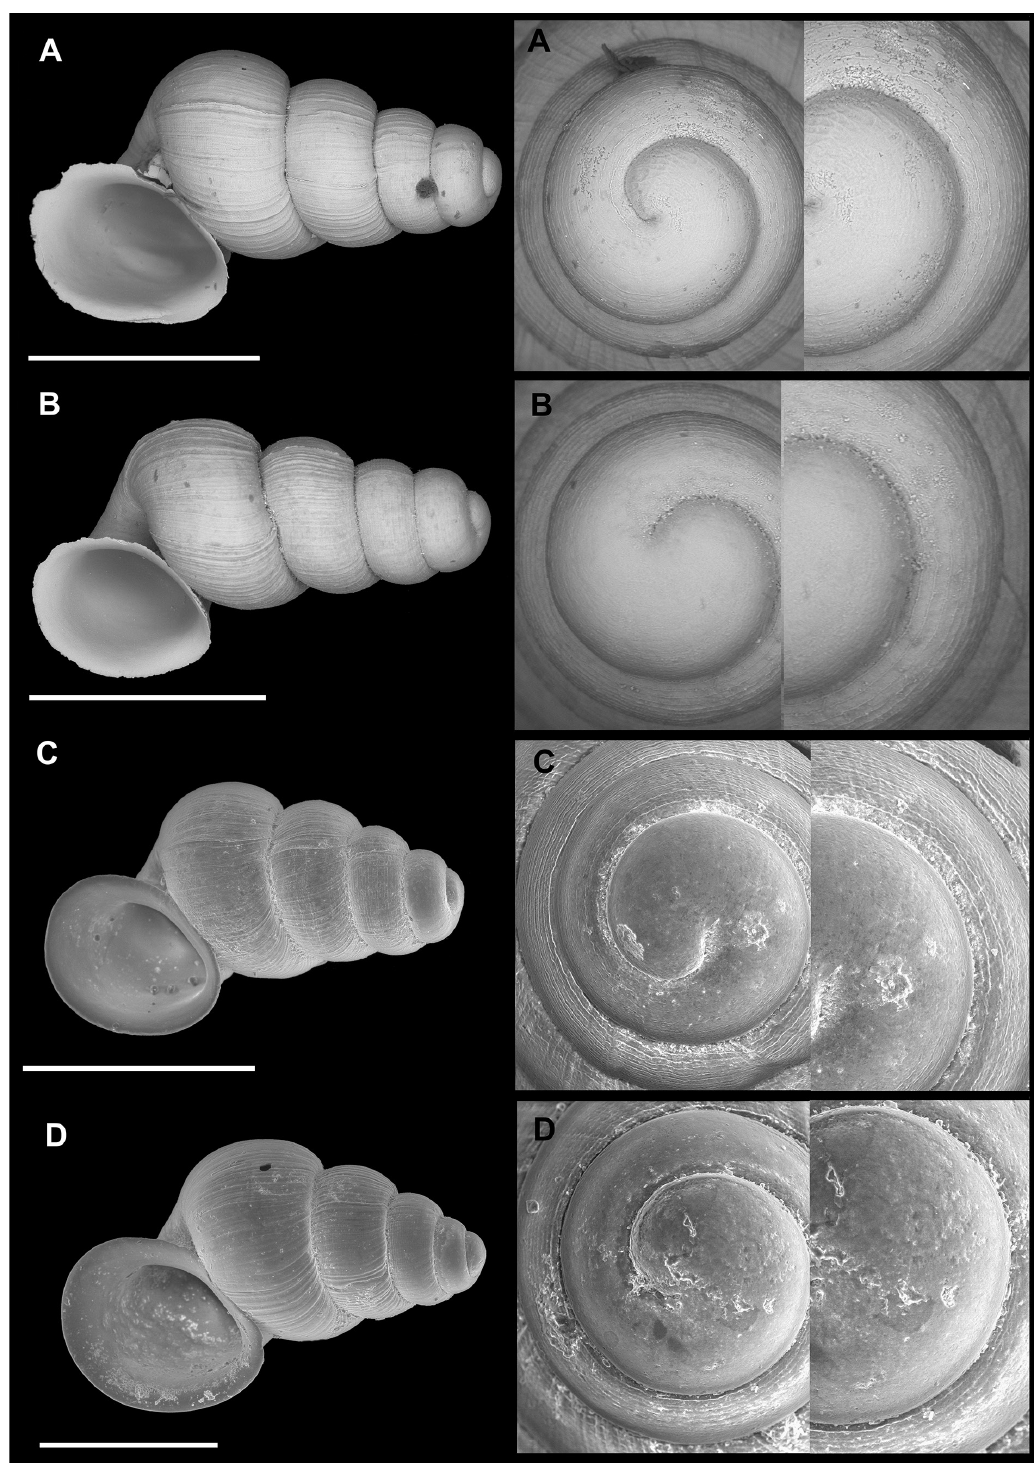
Fig. 6. A . Plagigeyeria ljutaensis sp. nov., Konjic, Vrelo Ljuta, paratype (SBMNH 626401). B . P. konjicensis sp. nov., Konjic, left side spring of Ljuta River, paratype (SBMNH 626249). C . P. plagiostoma (A. J. Wagner, 1914), Sarajevo, Ilidža, Vrelo Bosne, (SBMNH 632718). D . P. inflata (A. J. Wagner, 1928), Sarajevo, Ilidža, Vrelo Bosne (SBMNH 33032). Scale bars = 1 mm (SEM SBMNH Vanessa